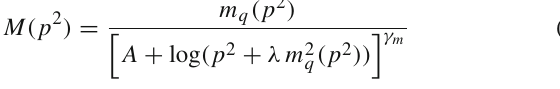
where γ m = 12 / 29 is the quark anomalous dimension for